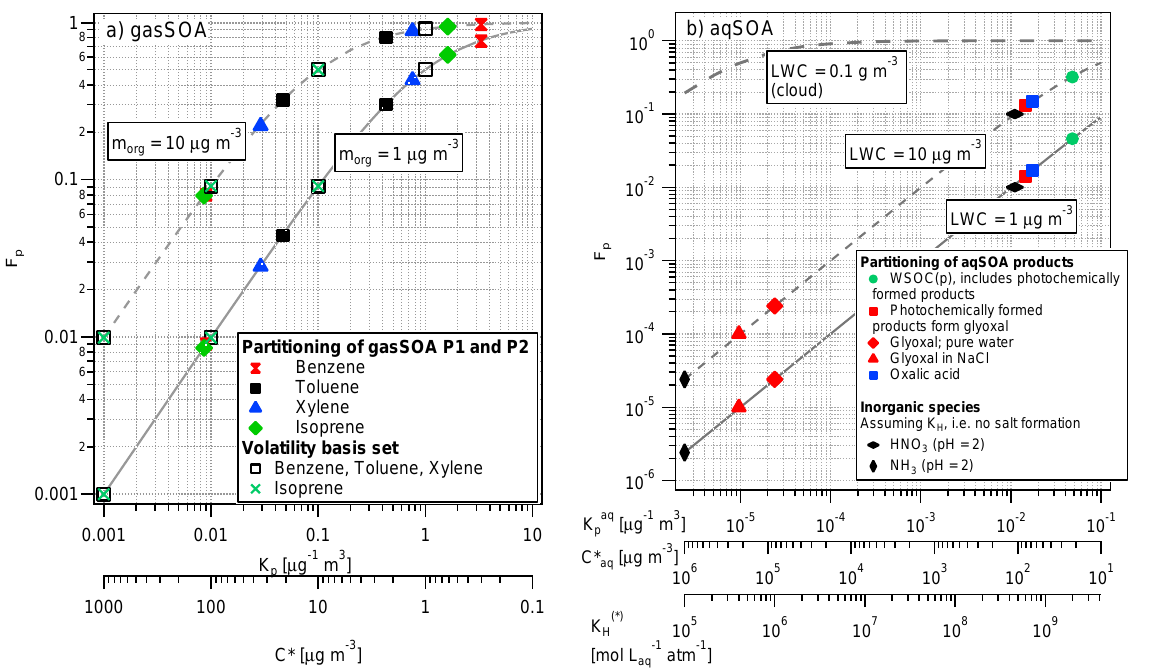
Fig. 4. Particulate fraction F p as predicted based on different SOA approaches (a) gasSOA is predicted based on 2-product model or VBS and displayed as a function of the partitioning constant Kp and saturation concentration C* for different amounts of organic aerosol mass. (b) aqSOA is shown as a function of K H (or K H *). This constant is converted to K aq p and C ∗ aq which corresponds to K p ( C ∗ ) for gasSOA but relates to water instead of absorbing organic material (Sect. 4.2.2). Values are shown for two different aerosol LWC; trends for cloud LWC are only shown as a